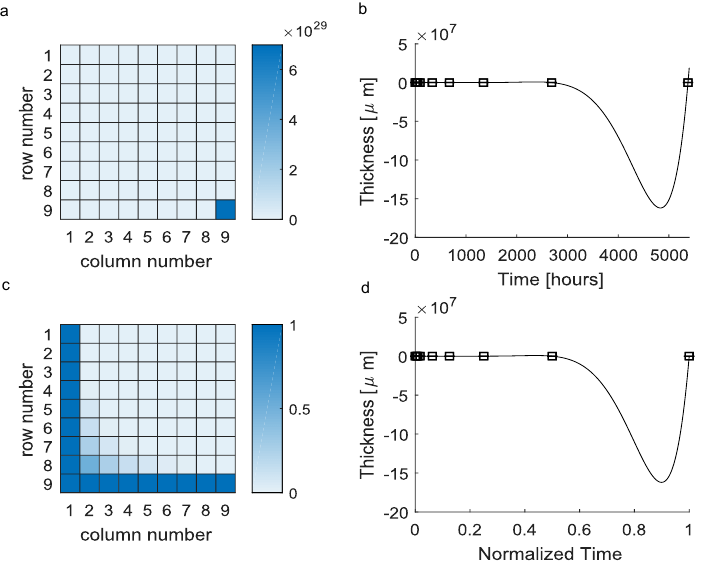
Figure 1. Vandermonde-based interpolation (black squares = mean experimental values, solid lines = theoretical predictions): ( a ) The huge difference among the element 9,9 and the other ones resulted in an ill-conditioned matrix. ( b ) The interpolating polynomial function was affected by the Runge phenomenon, resulting in nonphysical predictions for inter-interval values (negative values). ( c ) The normalization of times over the maximum experimental time lead to a better conditioned matrix. ( d ) Moreover, in the case of time normalization, the performances of the interpolating polynomials were